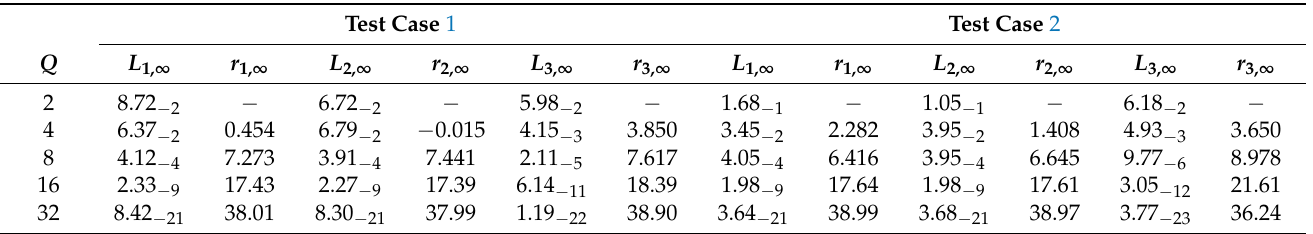
Table 7. The results of L ∞ norms, the corresponding convergence rate in Test Case 1 and 2 using the QLM-SMV procedure with diverse Q and d =